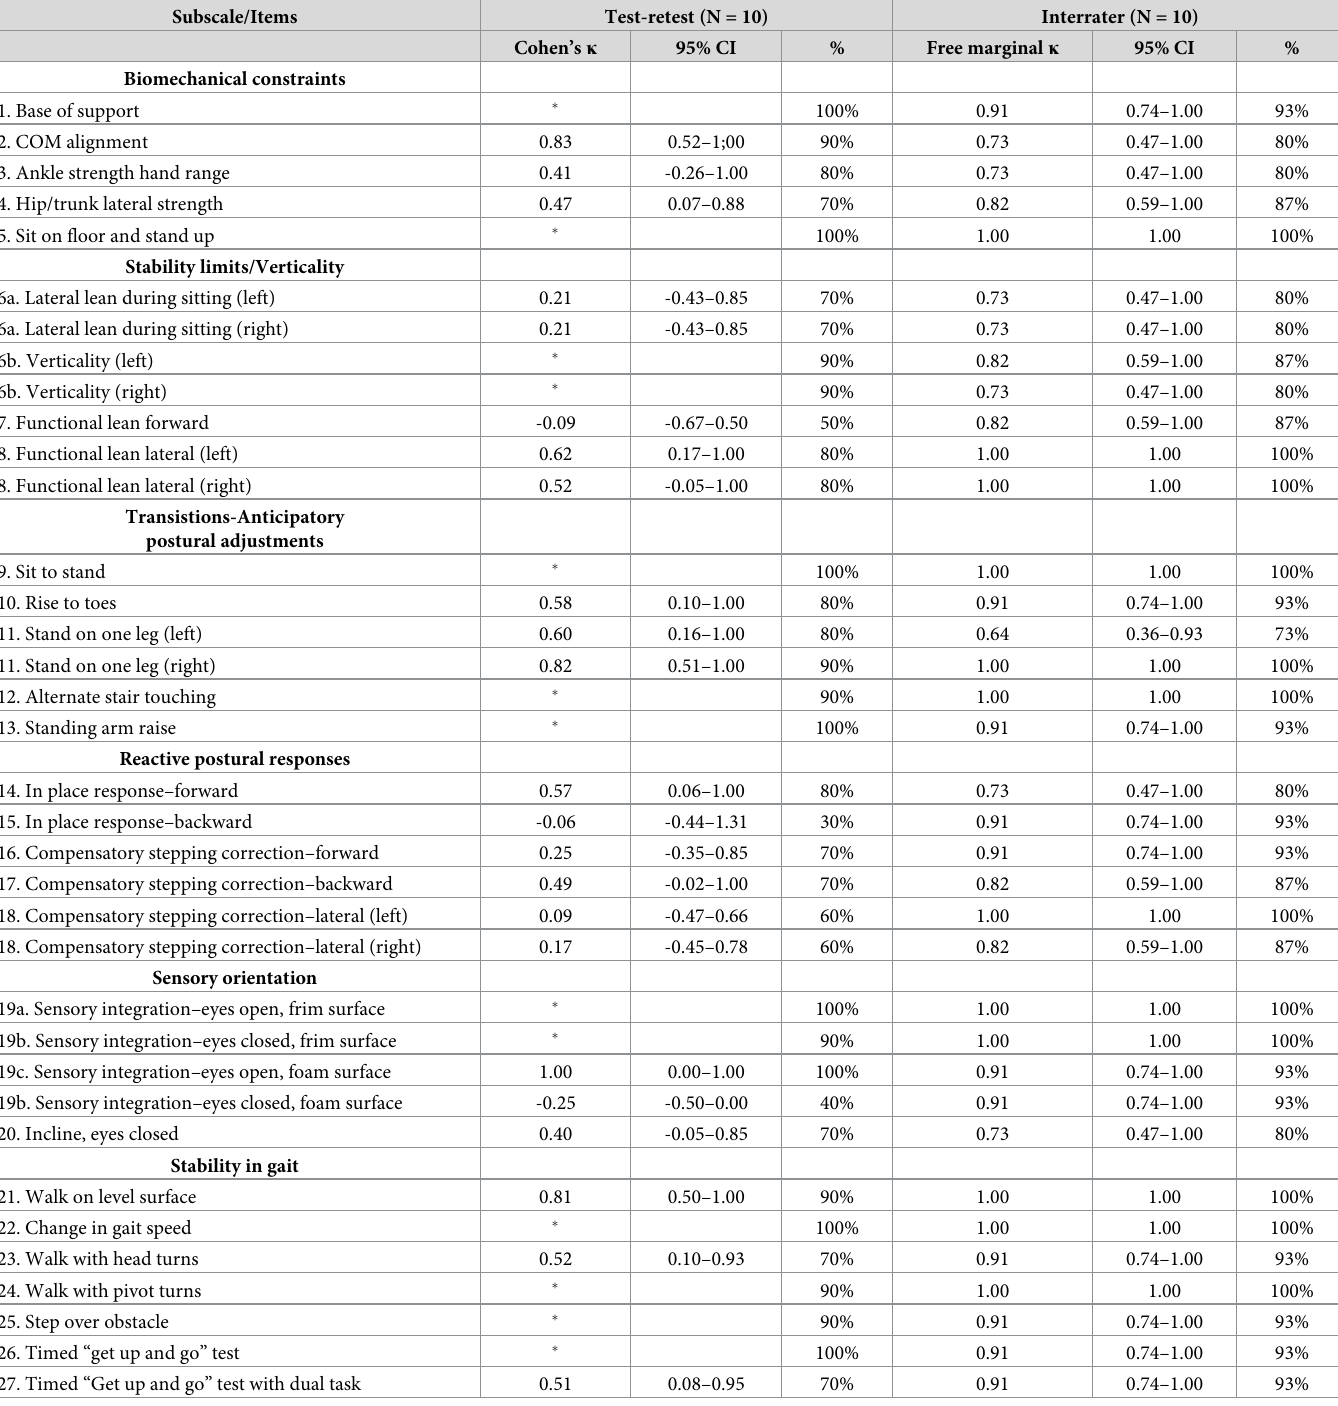
Table 4. Test-retest and interrater reliability of BESTest on item level.